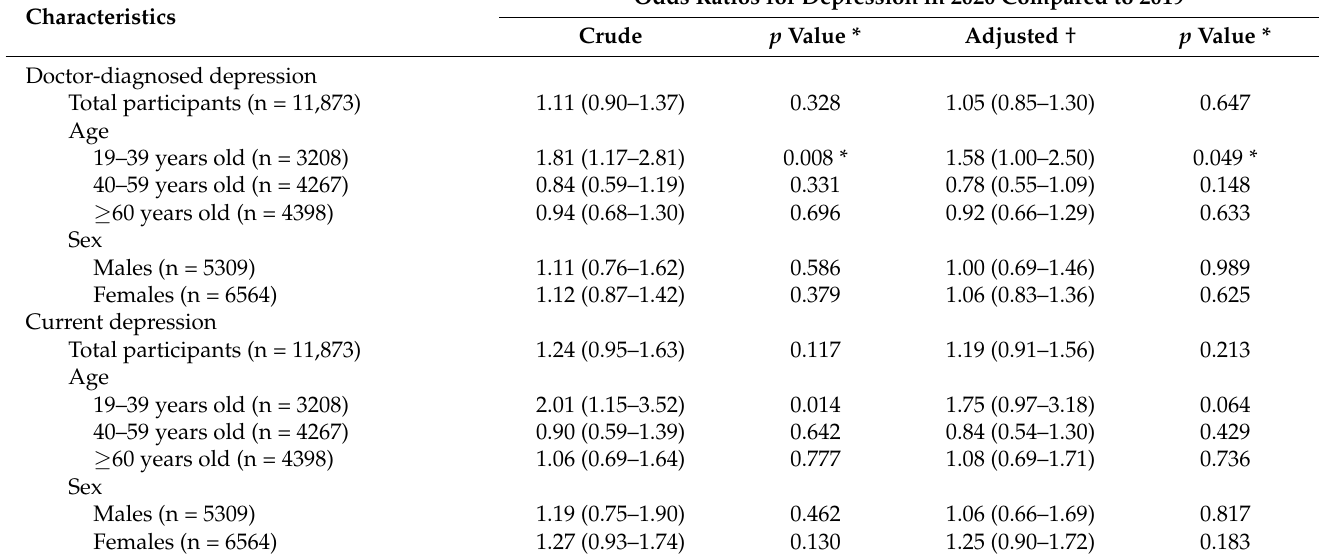
Table 2. Odds ratios (95% confidence intervals) for depression (doctor-diagnosed depression, current depression) in 2020 compared to 2019 with subgroup analyses according to age and sex.